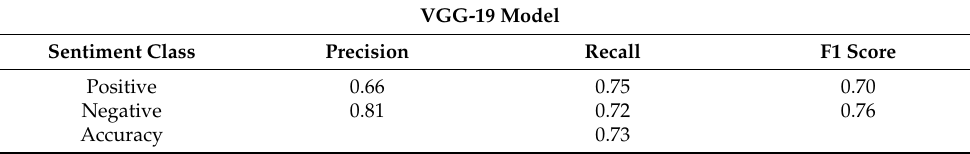
Table 5. Performance metrics of the VGG-19 model for image sentiment classification.